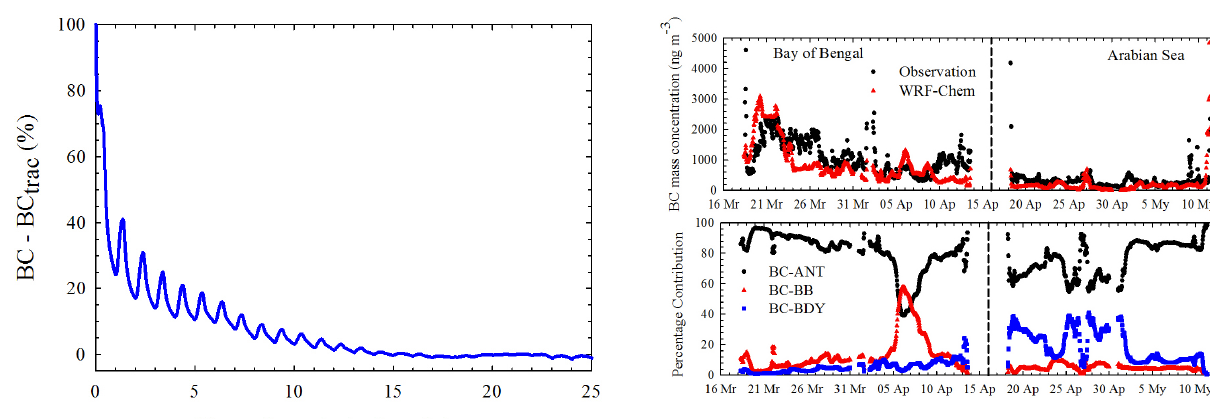
Figure 3. (a) WRF-Chem predicted and measured BC along the ICARB ship track during the ICARB period. (b) Percentage contri- butions of BC-ANT, BC-BB and BC-BDY to modeled BC.